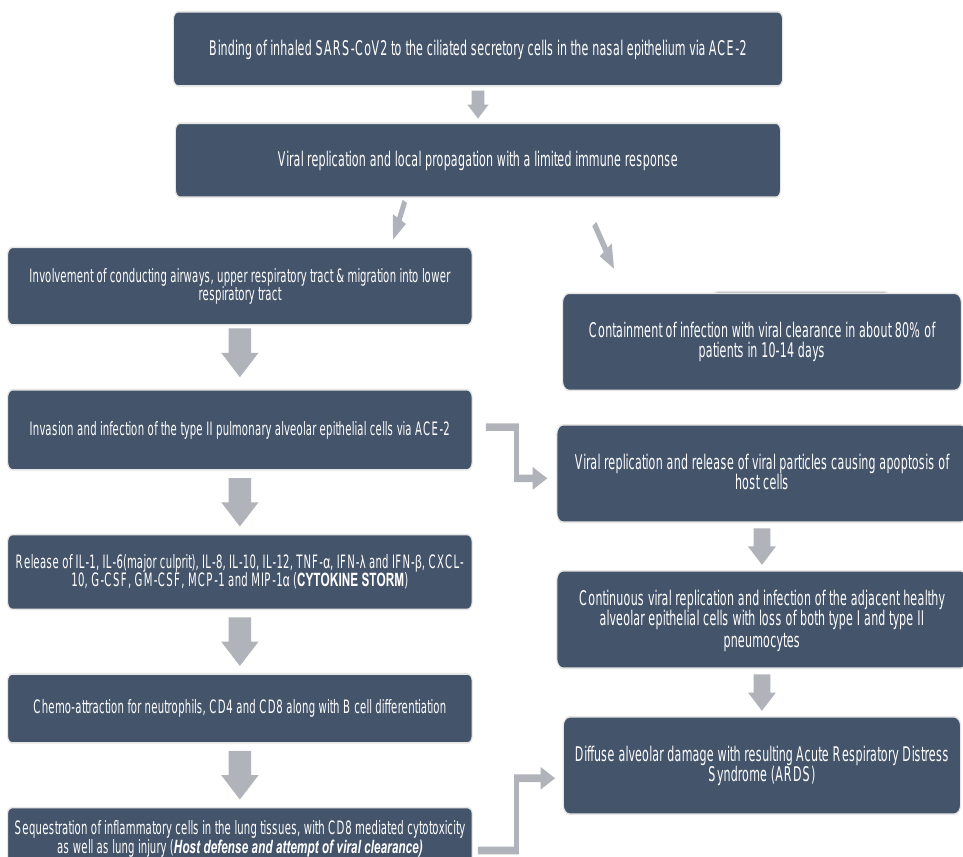
Figure 2. COVID-19 pathophysiology demonstrating disease progression from virus entrance in the body to causing acute respiratory distress syndrome (ARDS) [21].